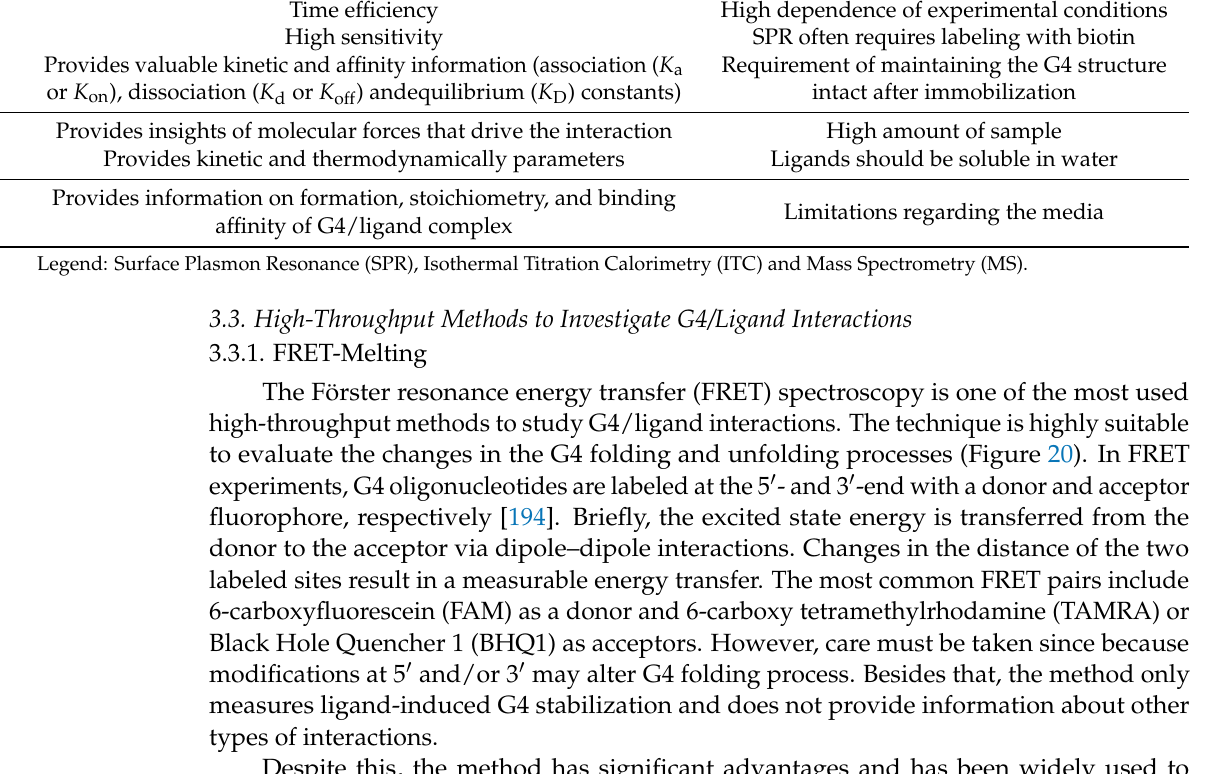
Table 2. Advantages and limitations of affinity and apparent affinity-based methods for investigating G4/ligand interactions. Method Advantages Limitations Requires sophisticated instrumentation and it Acquisition of data in real time is costly Time efficiency High dependence of experimental conditions SPR High sensitivity SPR often requires labeling with biotin Provides valuable kinetic and affinity information (association ( K a Requirement of maintaining the G4 structure intact after immobilization High amount of sample ITC Ligands should be soluble in